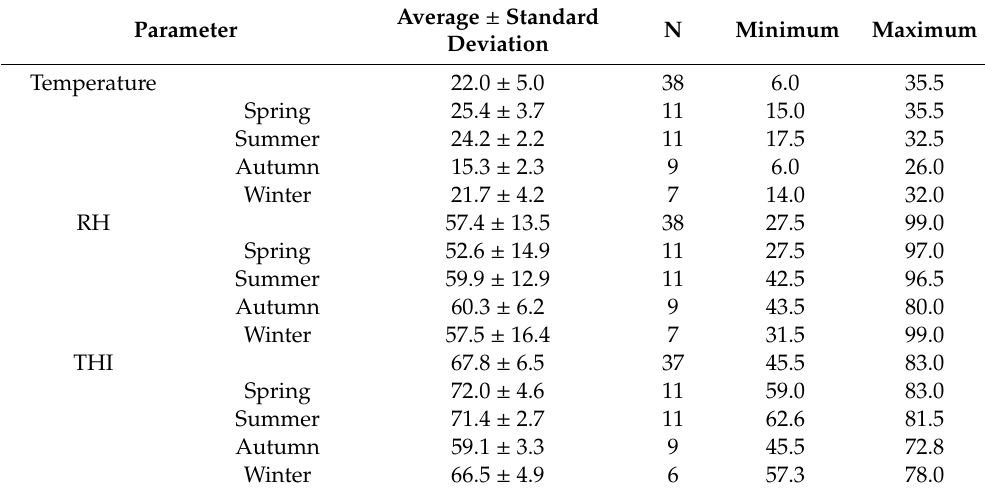
Table 3. The average, minimum and maximum temperature, RH and THI in the loading spaces. The average, minimum and maximum of each parameter was first calculated per transport and then per time